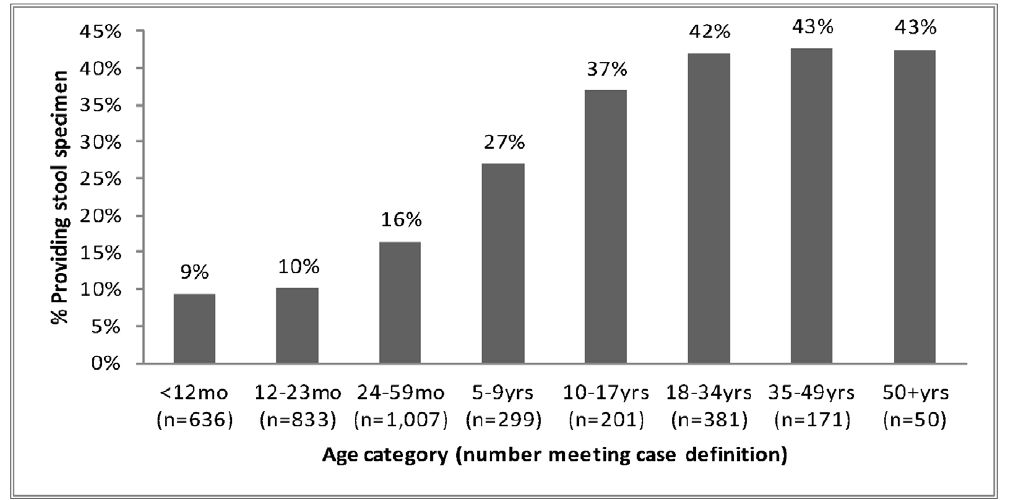
Figure 3. Proportions of patients meeting the case definitions providing stool sample by age category.